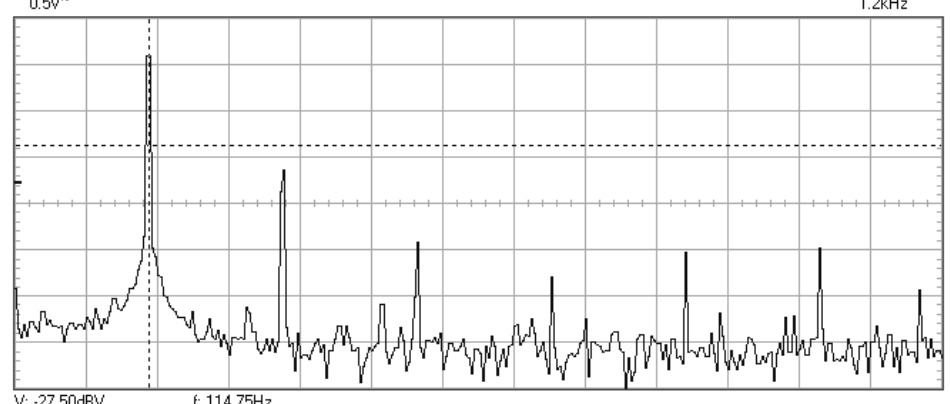
Figure 11. Amplitude spectrum recorded after 376,512 cycles at 118.4 Hz.